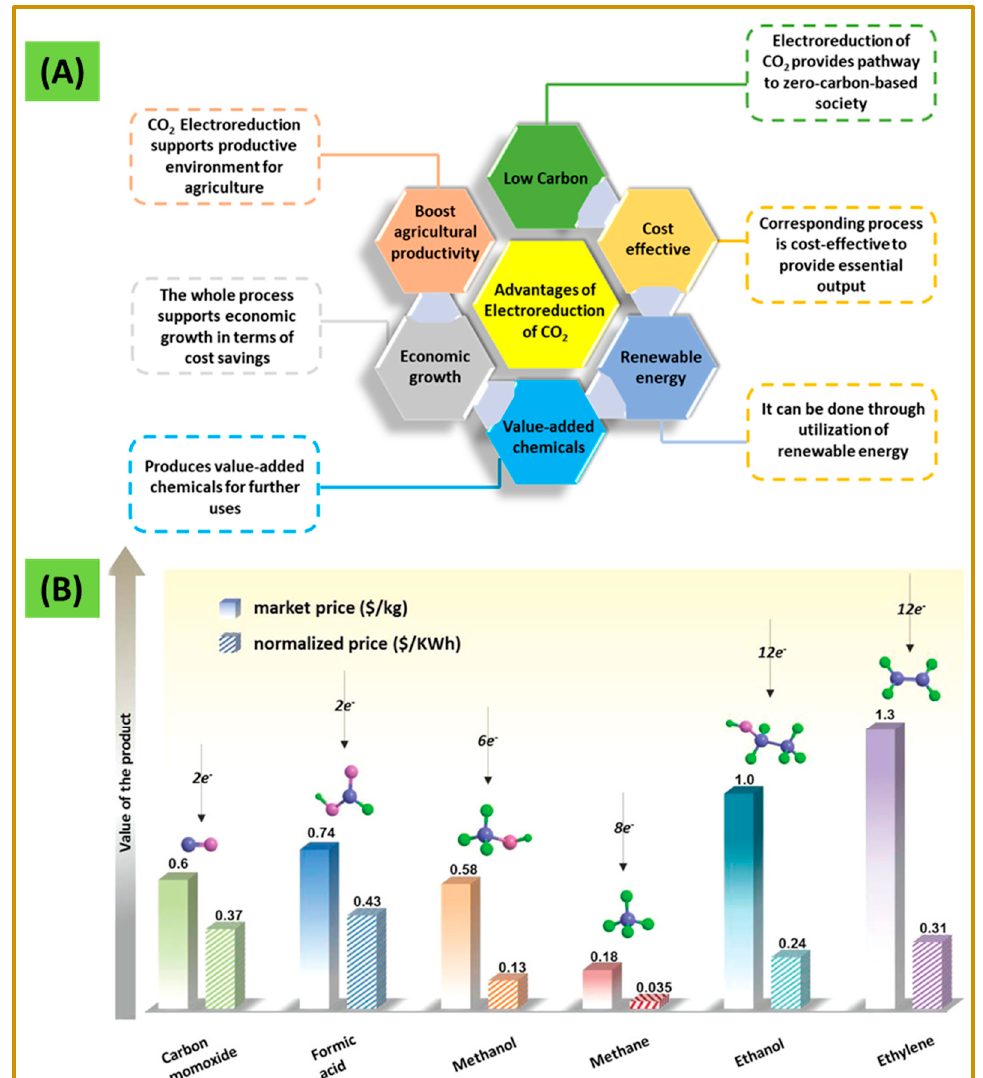
Figure 3. Illustration of the advantages of the electroreduction of CO 2 (ER-CO 2 ) ( A ) and a comparison of the market price values (USD per kg) of CO 2 -RR reduction products in terms of the electrical energy input (USD per kWh –1 ) ( B ) [11] (copyright: John Wiley and Sons, 2019).